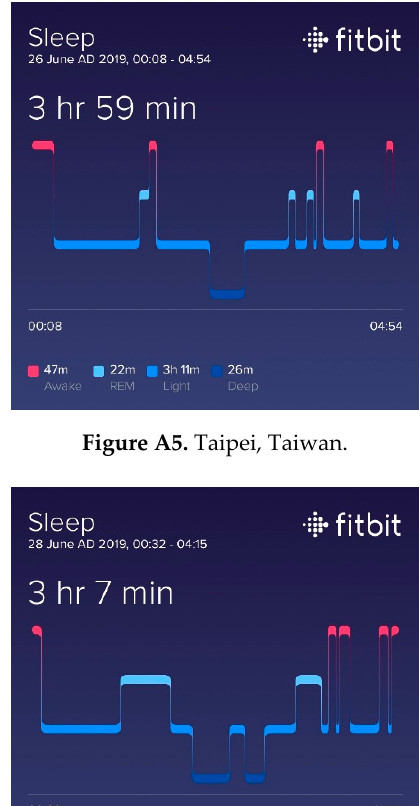
Figure A4. Guangzhou, China.